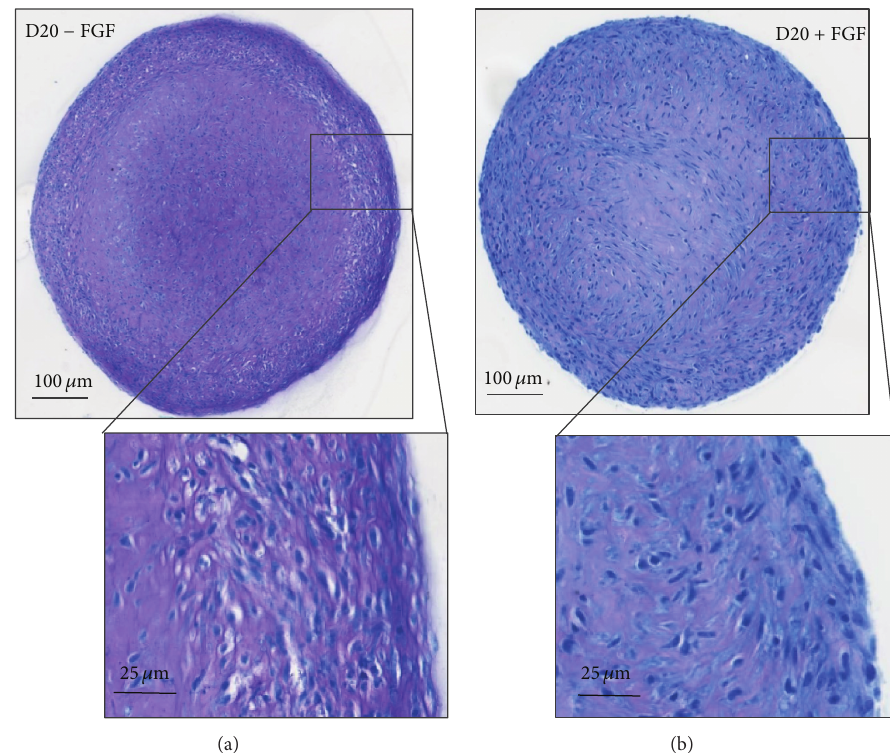
Figure8:Histologicalsectionsofchondrogenicpelletsonday20.Pelletsfromcellsexpandedincontrolmedium(a)ormediumsupplemented with FGF-2 (b) were stained with Toluidine